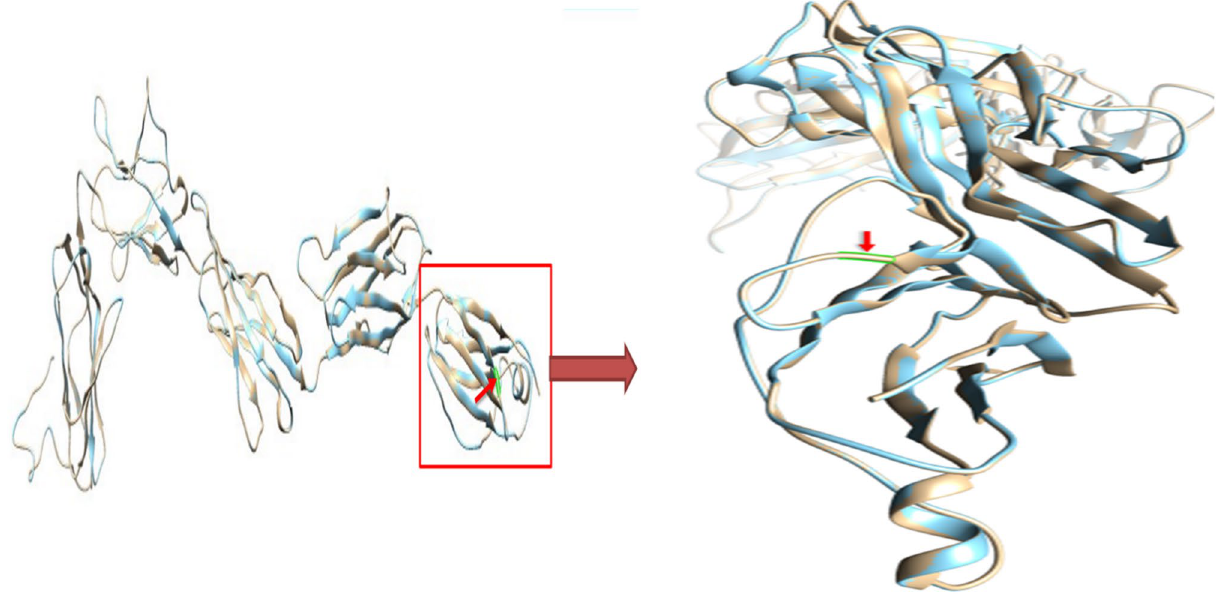
Figure 6. The highlighted region in this figure obtained through UCSF Chimera represents the altered site Arg420Gly in c-kit protein, identified in Acute myeloid Leukemia patients (n = 09).